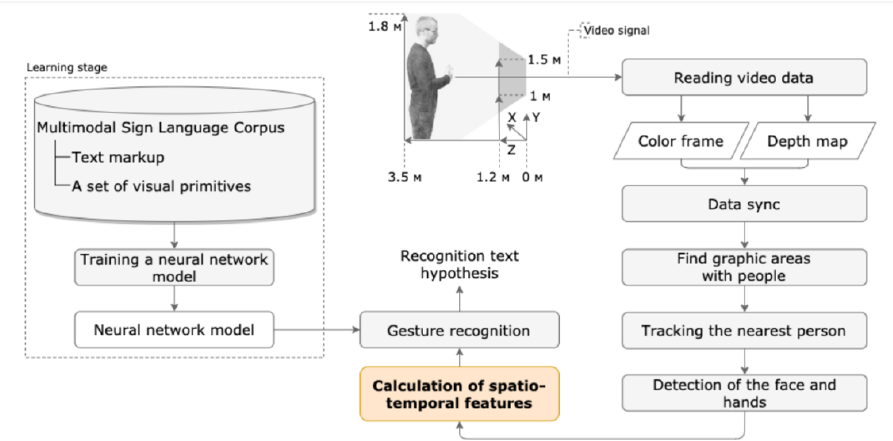
Figure 4. Functional diagram of the method of multimodal video analysis of hand movements and recognition SL elements. For each frame of both modalities, a search for graphic areas containing people is performed (Figure 3b). Then, the z-axis of the three-dimensional space (depth map) determines the nearest human and sets tracking for him (Figure 3c).